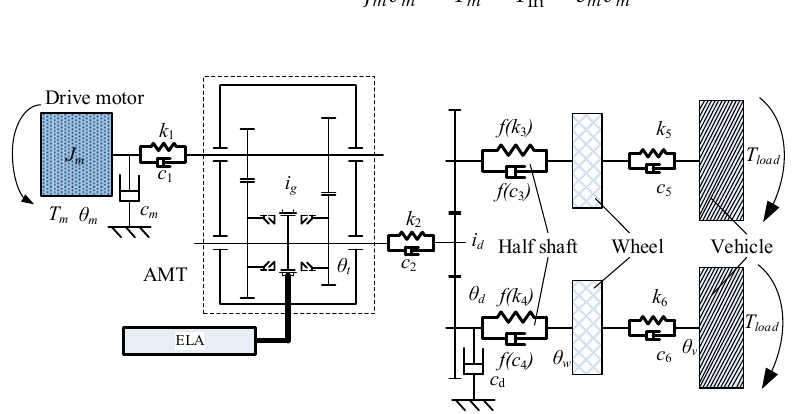
Figure 9. The vehicle model with motor-AMT coupled drive system.